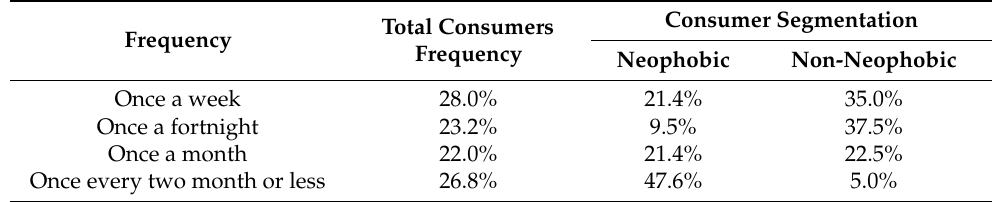
Table 6. Consumer segmentation using the Food Neophobia Scale (FNS). Consumer Segmentation Total Consumers Frequency Frequency Neophobic Non-Neophobic Once a week 28.0% 21.4% 35.0% Once a fortnight 23.2% 9.5% 37.5% 22.0% 21.4% 22.5% 26.8%